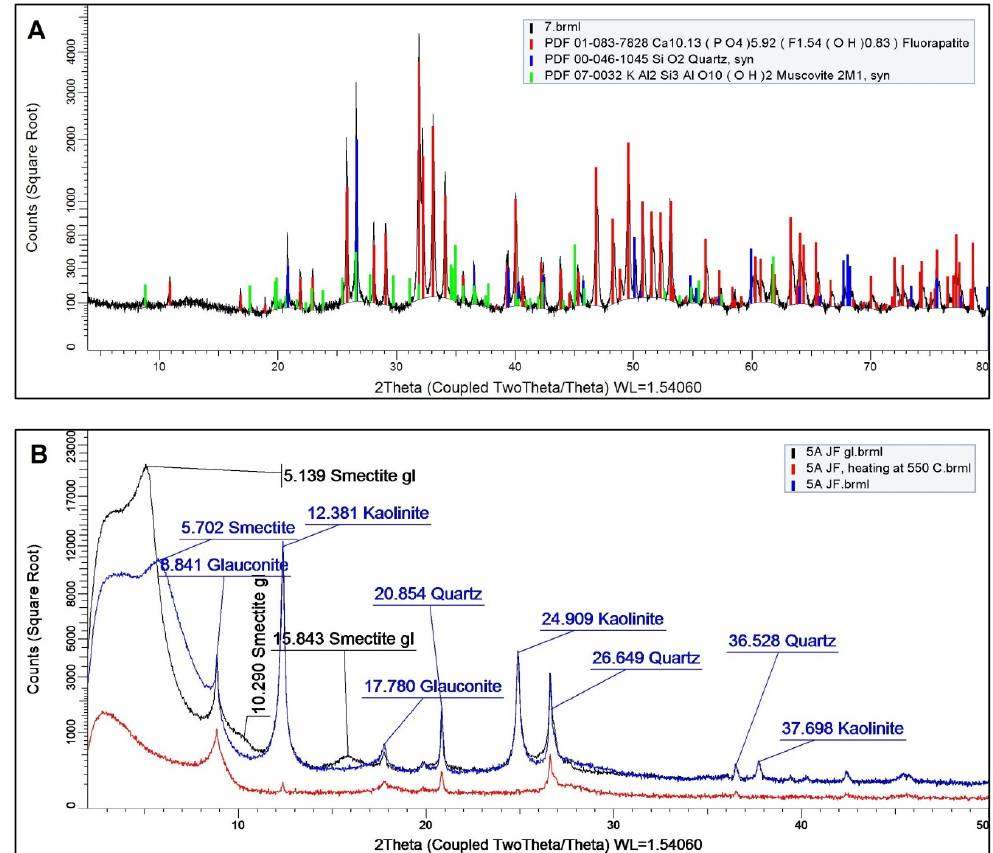
Figure 6. X-ray diffractograms of ( A ) phosphorite tube-fills in hardground at Č eská T ř ebová locality (present work) and ( B ) black mudstone ( − 2 μ m fraction) at the Cenomanian/Turonian boundary in the Pecínov quarry (adopted from Reference [13]).